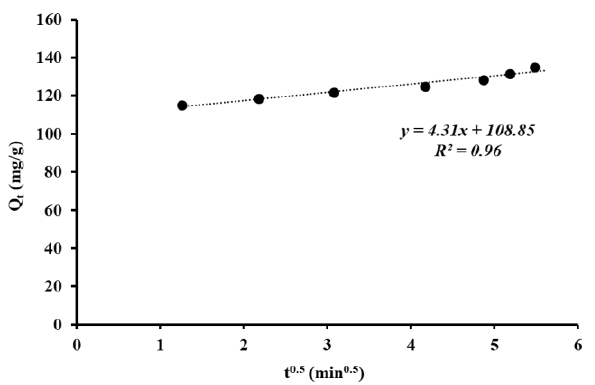
Figure 6. The kinetics of sorption by the porous polymer composite of 1 / 6-70-30 in the coordinates of the Weber–Morris model.